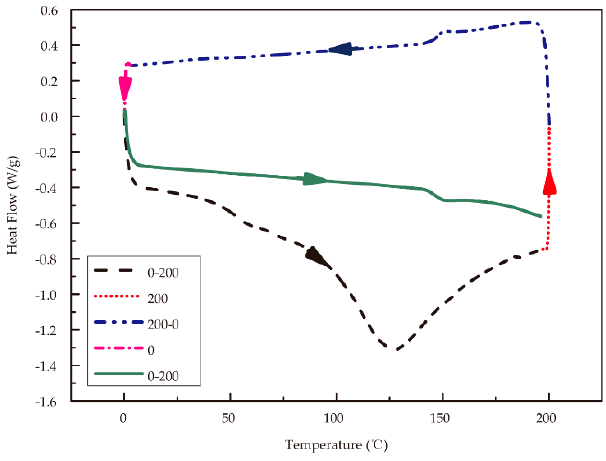
Figure 1. Heat-cool-reheat differential scanning calorimetry (DSC) scan process for RSF samples. Images of the RSF fibers were taken on a scanning electron microscope (SEM) (S4800, Hitachi, Tokyo, Japan) at a voltage of 3 kV.